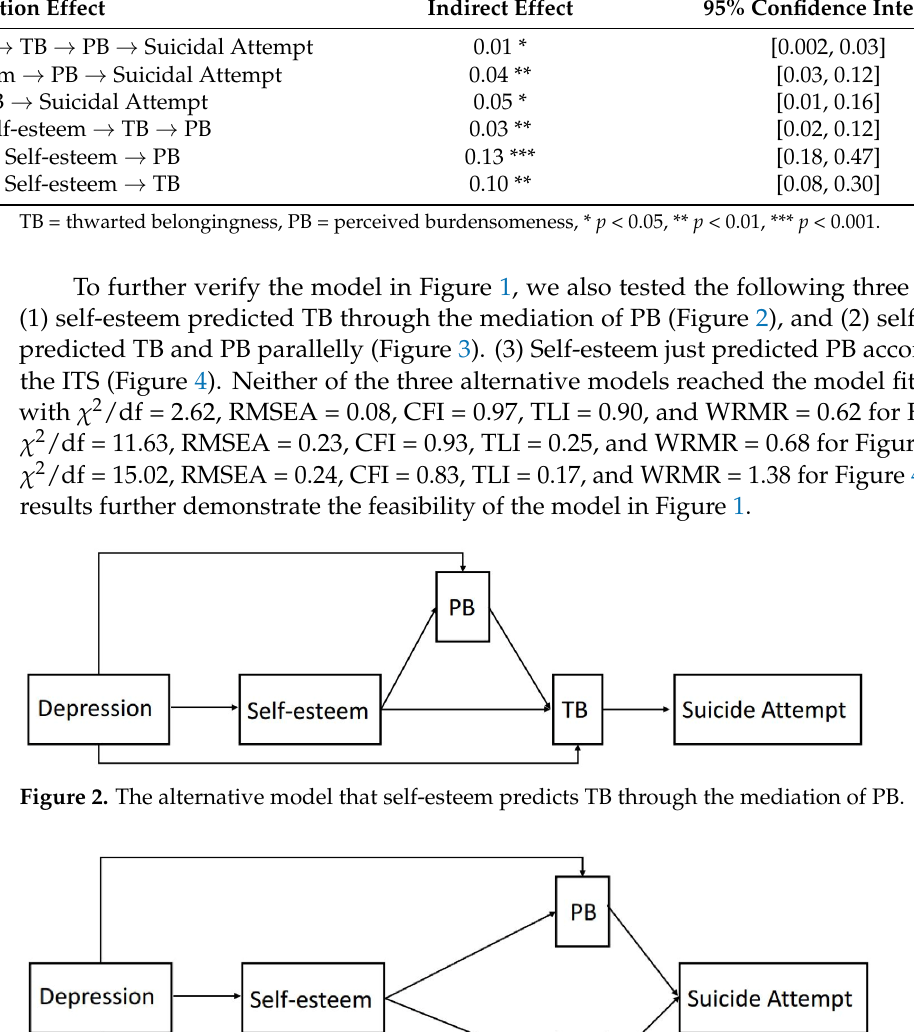
Figure 2. The alternative model that self-esteem predicts TB through the mediation of PB. Figure 4. The alternative model that self-esteem just predicts PB according to ITS. 4. Discussion This study aimed to testify the ITS in Chinese young people that could distinguish the only depressive group from the suicide attempt group and illuminate the transition mechanisms that led from depression to suicidal attempts. We found that in contrast to the only depressive group, the suicide attempt group reported a higher level of TB and PB. More importantly, the effect of depression on suicidal attempt was mediated by self- esteem, TB, and PB. Our findings make a theoretical contribution to the field by analyzing TB and PB’s effect on suicidal capability and the relationship between self-esteem and PB in the Chinese depressive social media user population. Consistent with previous research [44], no difference in gender, age, education level, marital status, or working status between the only depressive group and the suicide at- tempt group among Chinese social media users was found. Our findings also indicated that demographic characteristics are not helpful in distinguishing the only depressive group from the suicide attempt group in Chinese social media users, and further markers would be required to differentiate these two groups [45]. As expected, the suicide attempt group demonstrated a higher level of TB and PB than the only depressive group, which is consistent with previous studies [46,47]. Interestingly, the level of depression and self- esteem had no significate difference. One possible reason may be due to that all partici- pants were suicidal and depressed after screening. Depression and self-esteem have a close reciprocal relation, and low self-esteem is one of the features of depression [25], in- sofar as both groups’ score for self-esteem was lower than 2 (M = 1.93 for the depression, M = 1.84 for the attempted) in our study. This phenomenon also suggests that unlike TB and PB, depression and self-esteem do not play a role in screening for suicidal attempts in depressive groups. Because the mechanism among Chinese young people that contrib- utes to the transition from depression to suicidal attempts is not crystal clear, more re- search is required to investigate how these two groups are different in terms of self-es- teem, TB, PB, and other factors (e.g., biology, personality traits, and so on). Our findings suggest that the identification of high-risk cases will be facilitated by the TB and PB of depressed individuals.